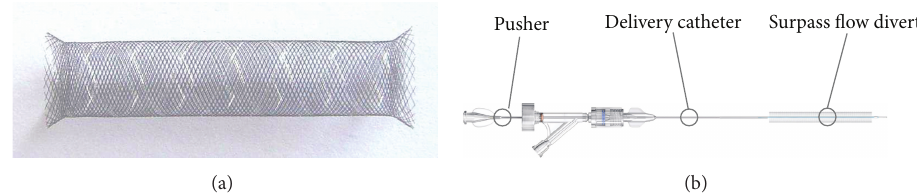
Figure 2: (a) The Silk flow diverter which is made of 48 braided nitinol strands with its flared ends. (b) The Surpass flow diverter which is made of cobalt-chromium alloy; also note the inner body that functions as a delivery wire. Reproduced with permission from (1) Balt Extrusion, Montmorency, France, and (2) Stryker Neurovascular.